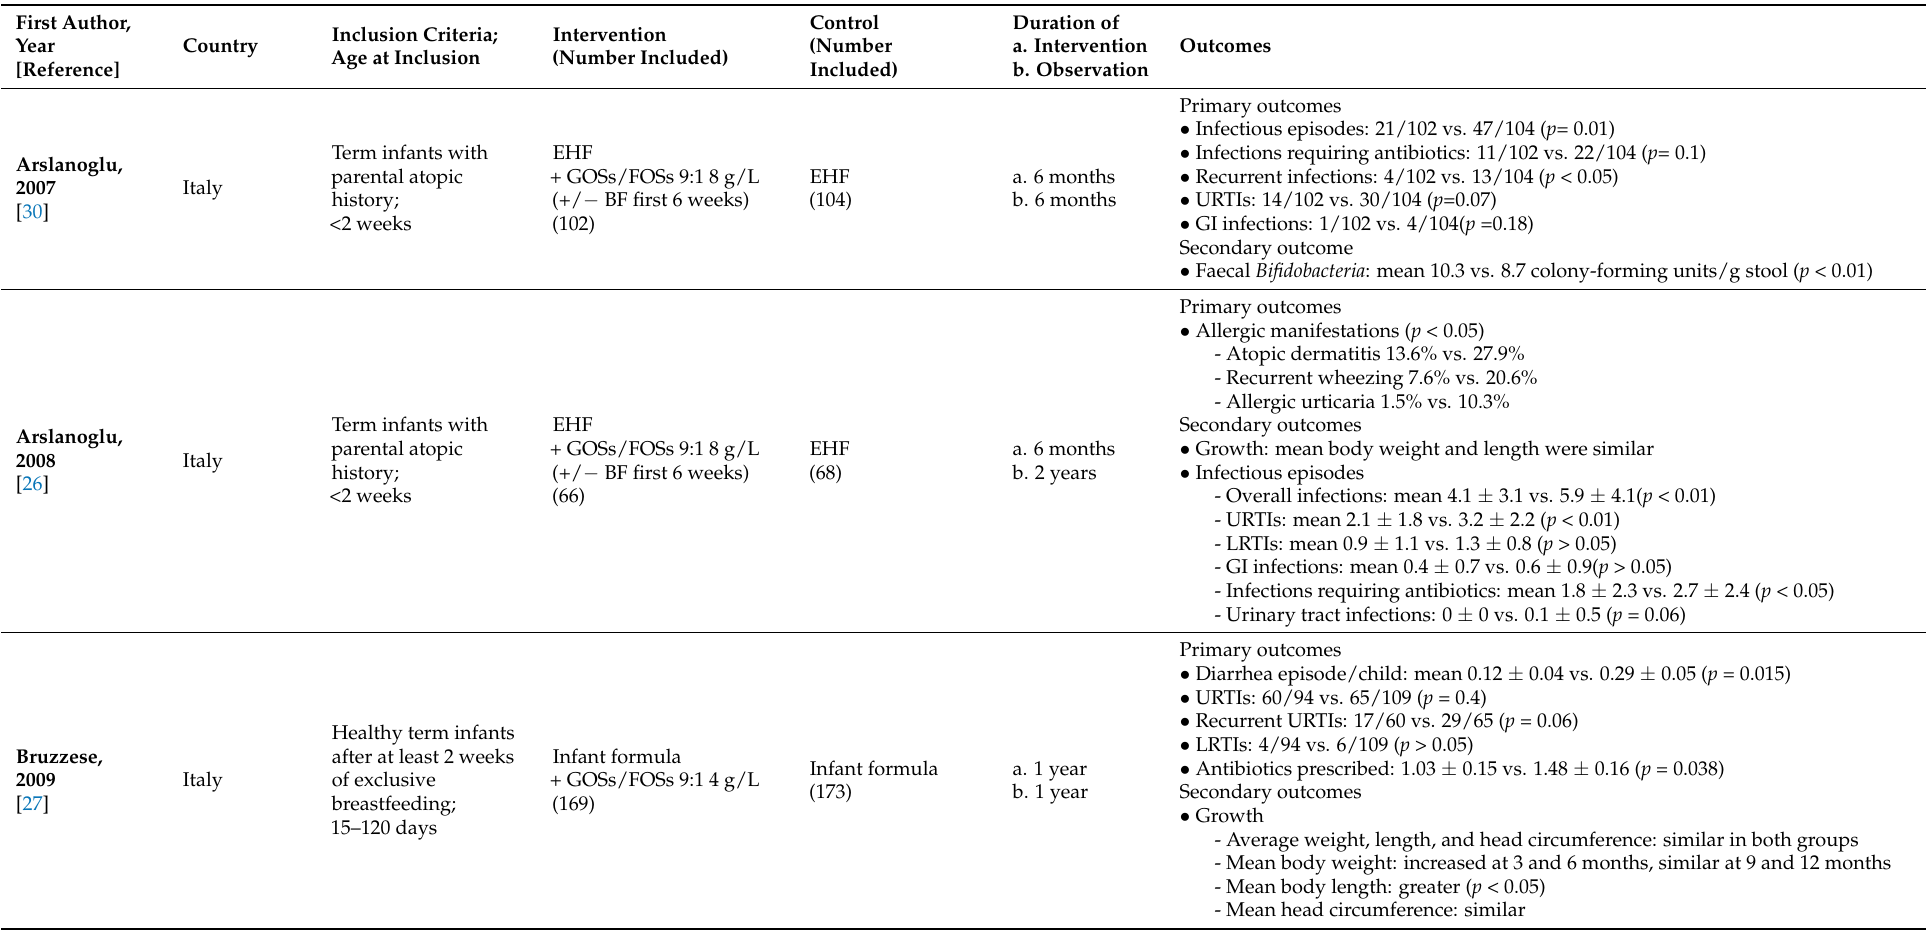
Table 2. Overview of references with